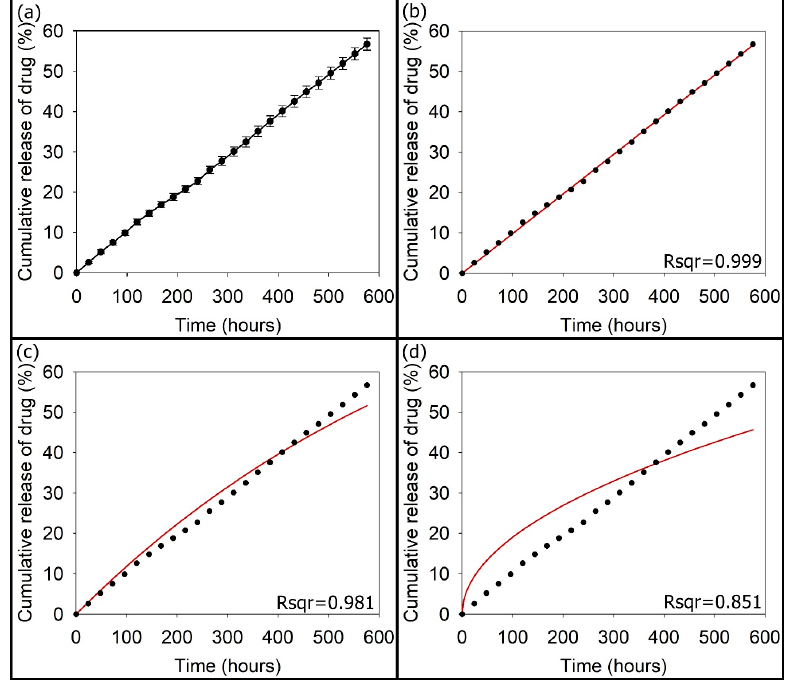
Figure 7. ( a ) In vitro cumulative tetracycline (TC) release from TC-loaded 3mSrHANFs. The curve was fitted with the equations of the ( b ) zero-order, ( c ) first-order, and ( d ) Higuchi models.